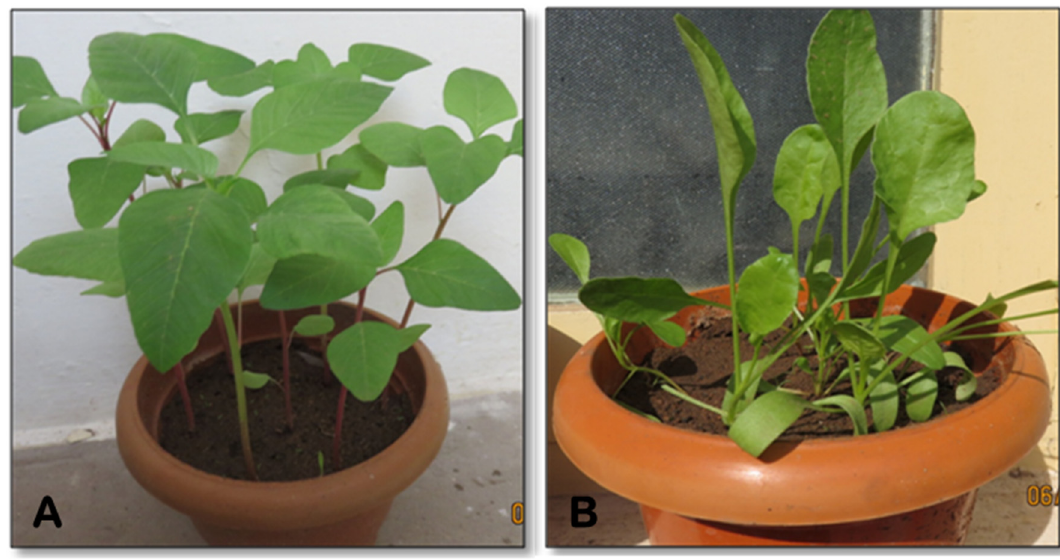
Figure 6. Semiquantitative reverse-transcriptase PCR of GmIFS in infiltrated samples. ( A ): Lane 1: DNA Marker; lane 2: A. tricolor var. tristis control (wild type); lane 3: A. tricolor var. tristis infiltrated with pEAQ-HT-DEST 3: IFS ; lane 4: A. tricolor var. tristis infiltrated with pEarleyGate 102 HA :IFS ; lane 5: S. oleracea control (wild type); lane 6: S. oleracea infiltrated with pEAQ-HT-DEST 3 :IFS ; lane 7: S. oleracea infiltrated with pEarleyGate HA 102 :IFS ; lane 8: positive control (pEAQ-HT-DEST 3 :IFS plasmid). ( B ): β -Actin internal control. 2.3. HPLC Detection of Naringenin and Genistein in Infiltrated Samples HPLC was performed to determine the presence of naringenin in wild-type A. tricolor var. tristis and S. oleracea followed by genistein detection in the infiltrated leaves. The re- sults showed that the naringenin peaks were observed in both the plant species corre- sponding to that of naringenin standard. Wild-type A. tricolor var. tristis and S. oleracea showed 265.5 and 338.5 nM/g FW (nanomolar/gram fresh weight) of naringenin in the plant extracts. In the control samples, S. oleracea showed higher levels of naringenin con- tent when compared to A. tricolor var. tristis . (Figure 7). Consequently, the naringenin con- tent was also determined in the agroinfiltrated A. tricolor var. tristis and S. oleracea with pEarleyGate 102 HA and pEAQ-HT-DEST 3 vectors harboring IFS . As shown in Figure 7, the leaves of A. tricolor var. tristis and S. oleracea infiltrated with pEarleyGate 102 HA and pEAQ-HT-DEST 3 showed considerably less concentration of naringenin varying in the range of 65.5–134 nM/g FW compared to control.